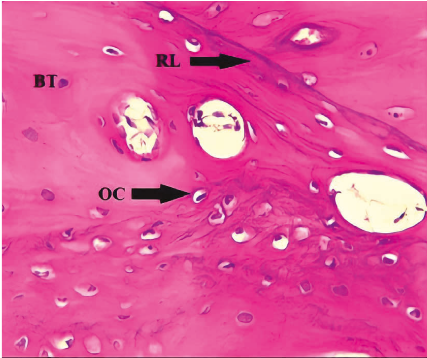
Figure 4: A view of the defect site in the C group shows numerous irregular OC trapped in bone trabeculae (BT) and reversal lines (RL) (arrows) after 4-weeks. H&E x40.